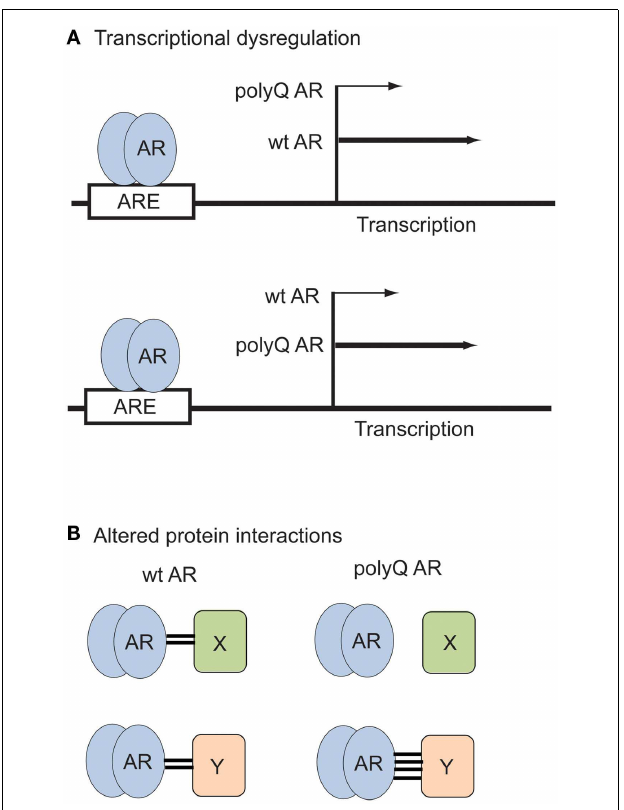
FIGURE 2 | Examples of polyQAR loss- and gain-of-function in SBMA . (A) Transcriptional dysregulation.The polyQ AR may activate expression of certain genes to a lesser (top) or greater (bottom) extent than the wt AR. (B) Altered protein interactions.The polyQ AR may fail to associate with proteins (top) or bind more strongly to proteins (bottom) that normally interact with the wt